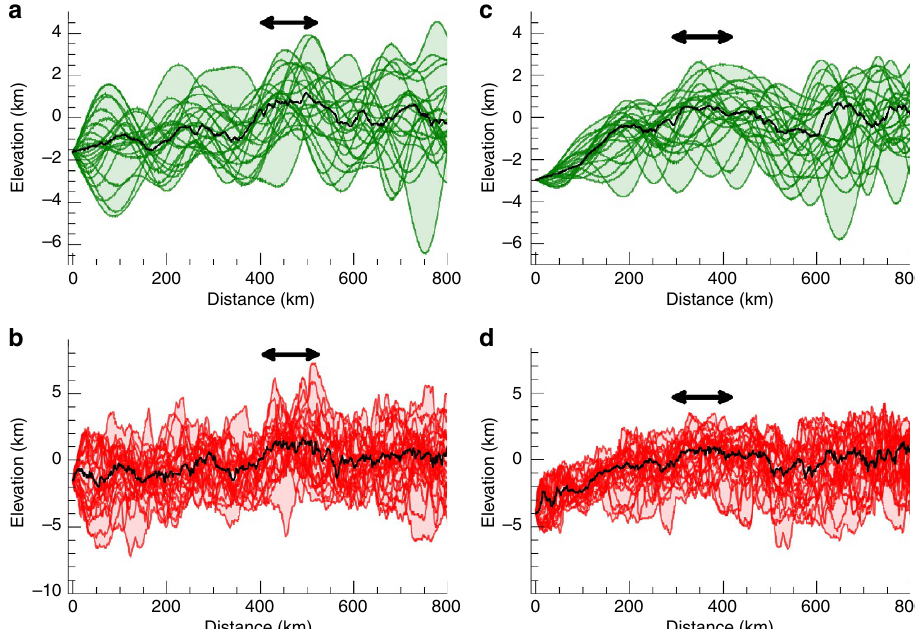
Figure 8 | Planitia B and C topographic profiles. ( a , b ) Filtered and real topography for planitia B; ( c , d ) Filtered and real topography for planitia C. Black lines are the median of the profiles. Elevations are computed with respect to the 482 (cid:3) 482 (cid:3) 446km ellipsoid 7,16 . Distance is computed along the surface of the best ellipsoid. Topographic profiles are for increments of 15 (cid:2) in azimuth starting from the centre of the feature. Black arrows indicated the position of the rims.